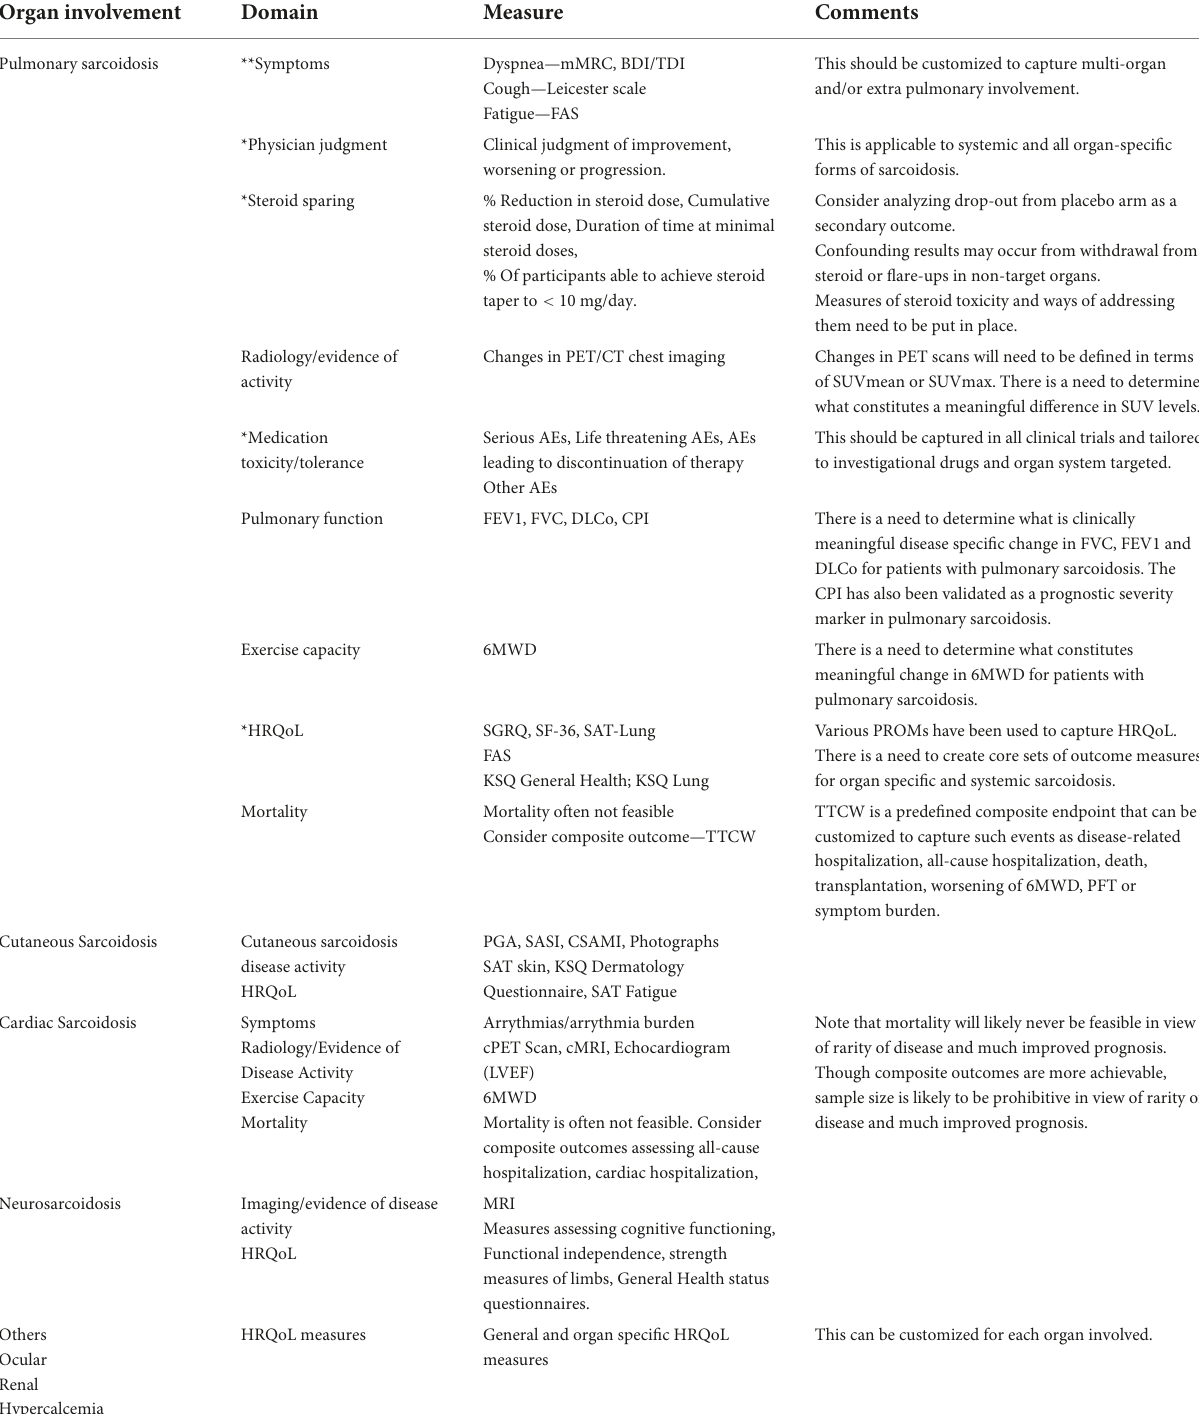
TABLE 2 Proposed endpoints for clinical trials in sarcoidosis (5, 21,